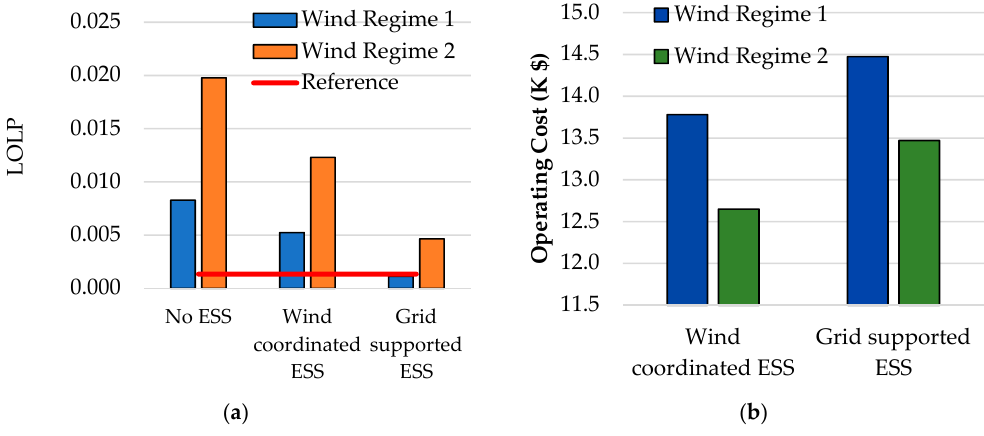
Figure 10. Impact of operational strategy and wind regimes on ( a ) operational adequacy and ( b ) operating cost.